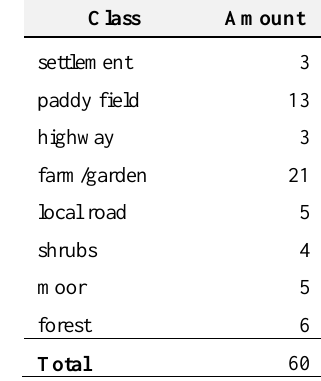
Table 6b. Classification result from orthophoto data, which divided into specific area study